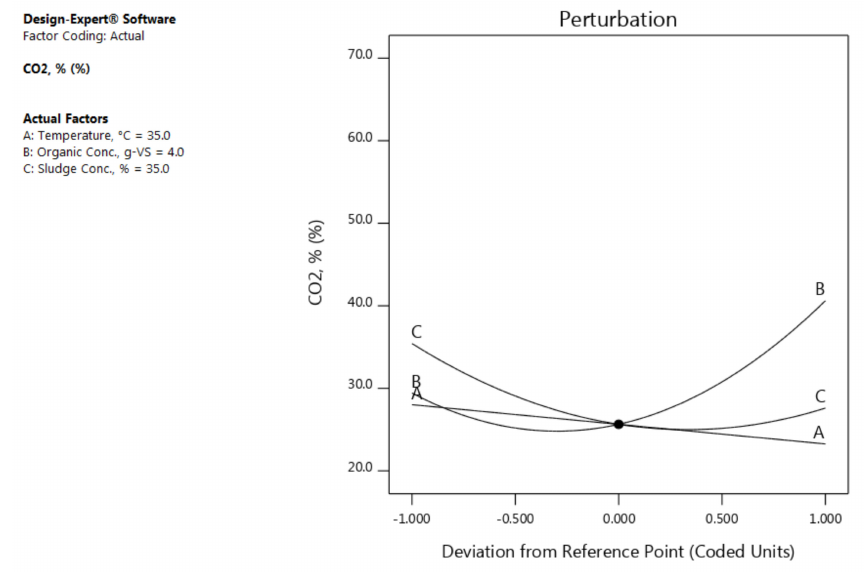
Figure 7. Scatter plot of the predicted values versus the actual values of the CO 2 % response.